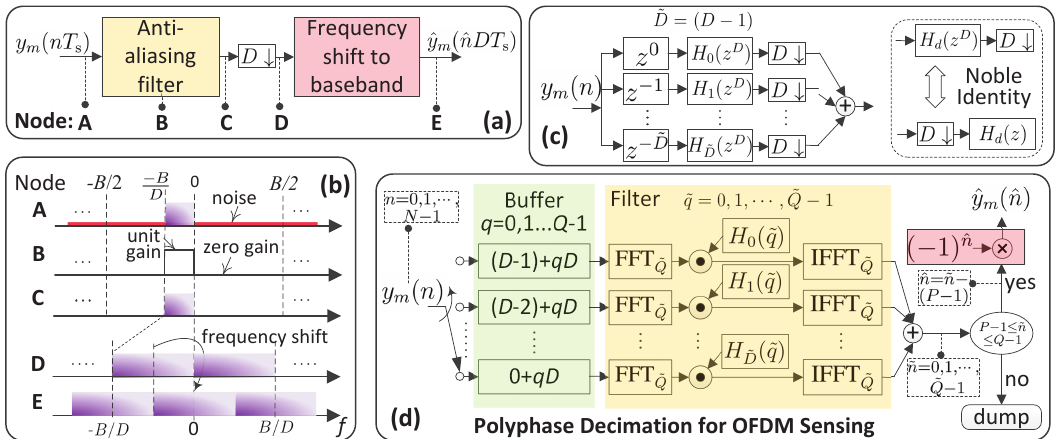
Figure 7. ( a ) Illustration of general steps for decimation; ( b ) spectrum features at different stages of decimation; ( c ) decomposing the anti-aliasing filter in ( a ); ( d ) the polyphase structure-based decimation specifically tailored for OFDM